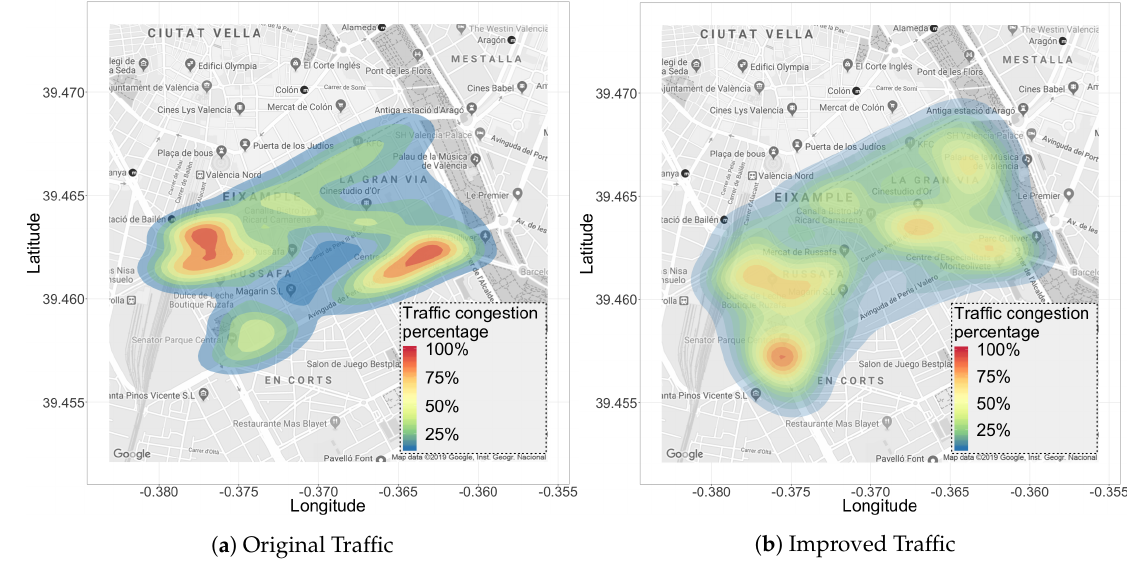
Figure 11. Heatmap of traffic congestion for the city of